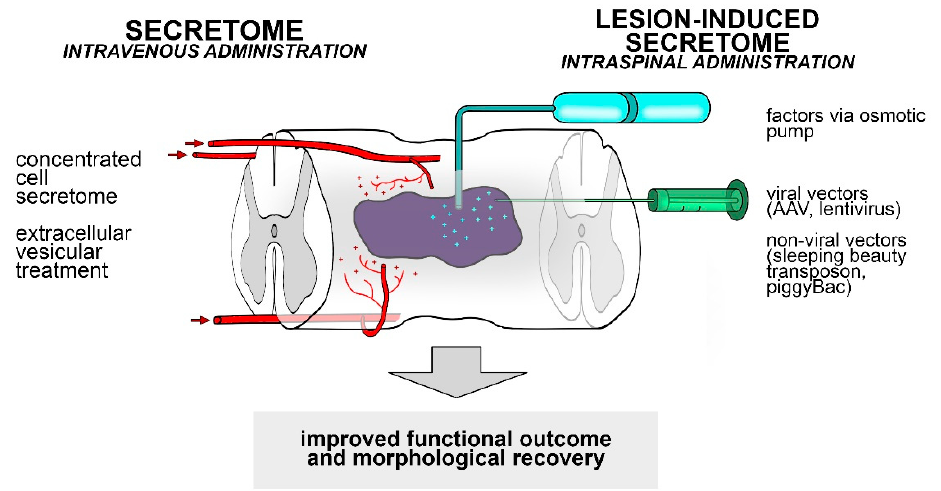
Figure 3. Application of the secretome and lesion-induced secretome via different administration routes. Intravenous administration of the secretome (concentrated cell secretome, extracellular vesicular treatment) produced by MSCs is able to promote neuroregeneration and neuroprotection ( left ). Intraspinal delivery of the lesion-induced secretome to the lesion site by various administration routes such as osmotic pumps and different vectors may be able to induce axonal regeneration and neuroprotection ( right ).